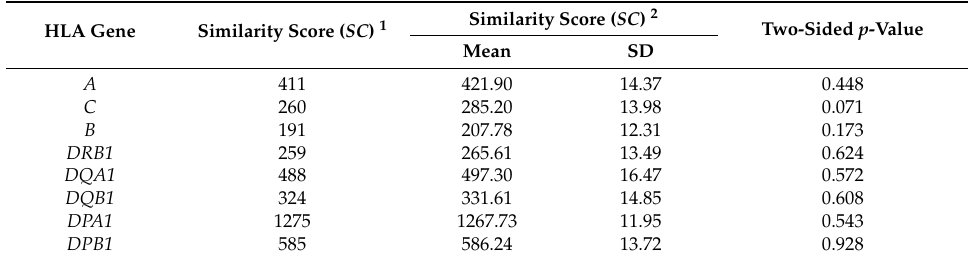
Table 2. Summary of similarity scores ( SC ) for each HLA gene (at four-digit resolution) in HRS European Americans.